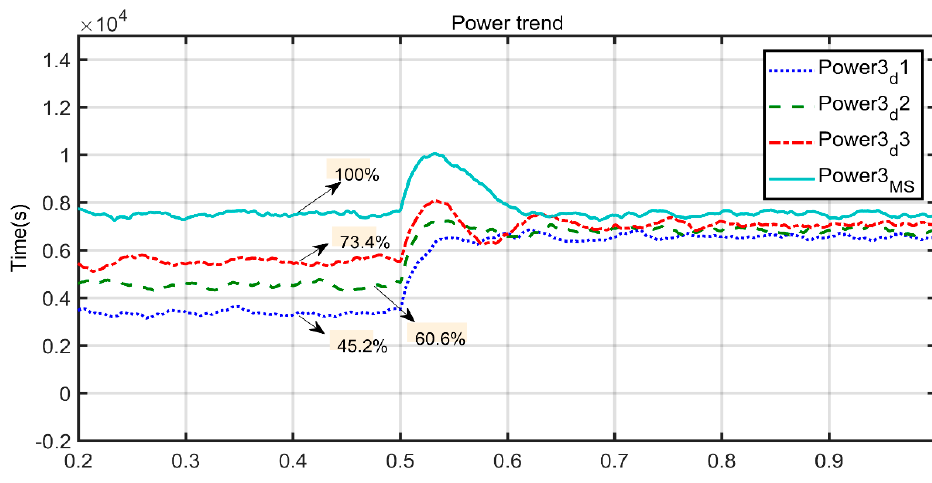
Figure 15. Power-delivered comparison.